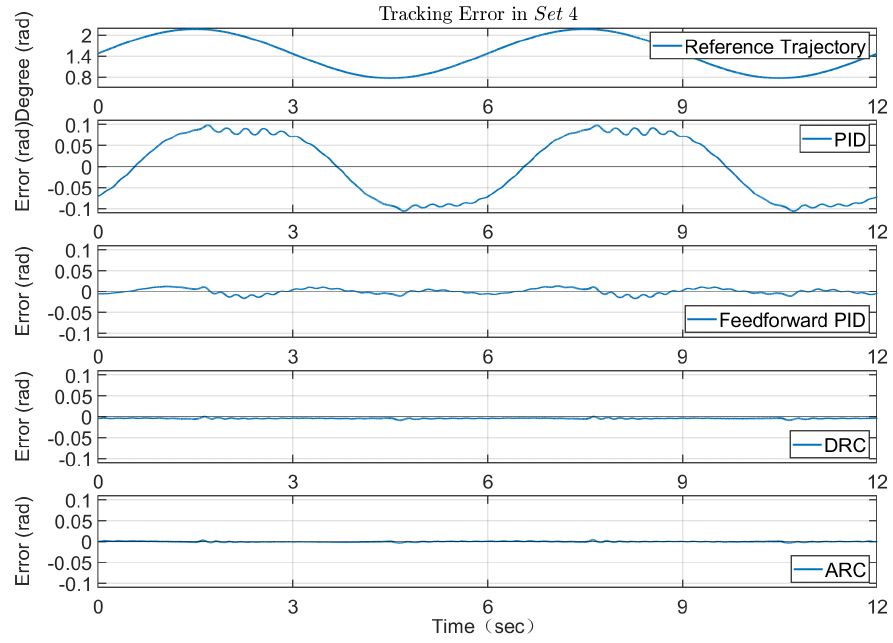
Figure 7. Sinusoidal trajectory tracking error comparison diagram with Posture